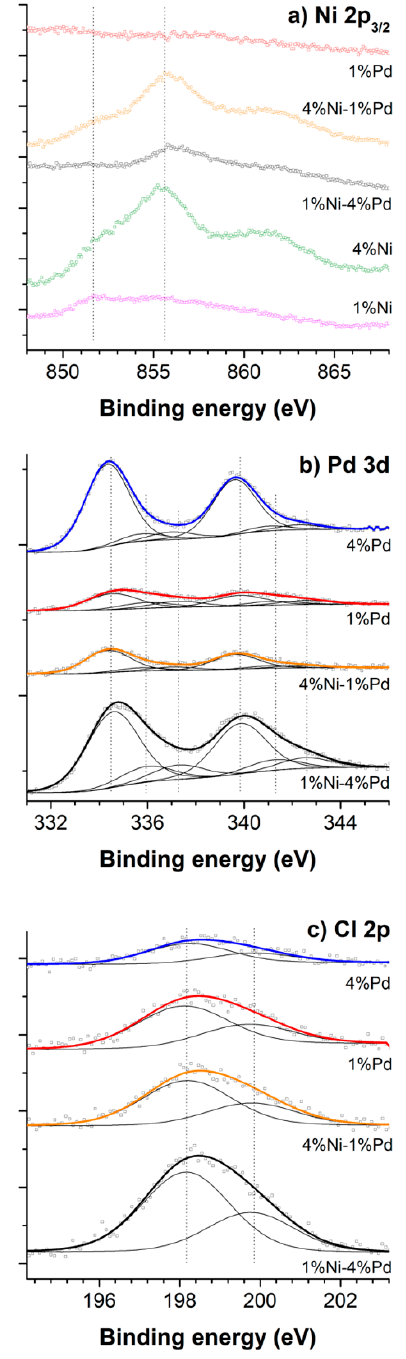
Figure 2. ( a ) Ni2p 3/2 , ( b ) Pd3d, ( c ) Cl2p orbital XPS spectra of the mono and bimetallic